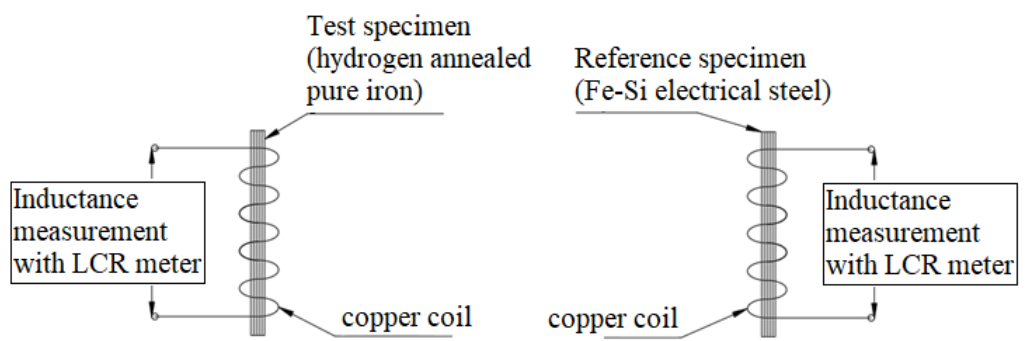
Figure 11. Schematic arrangement in the test set up to estimate relative permeability.